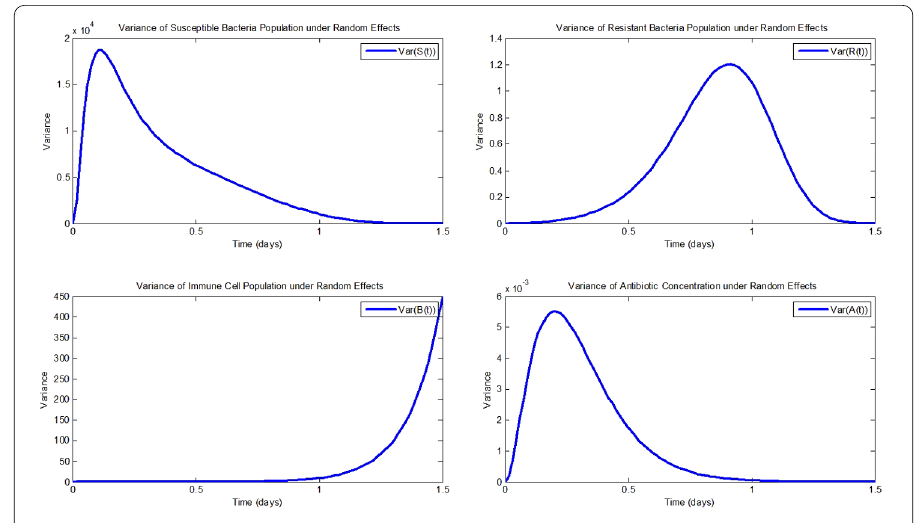
Figure 7 Variances of the random model.